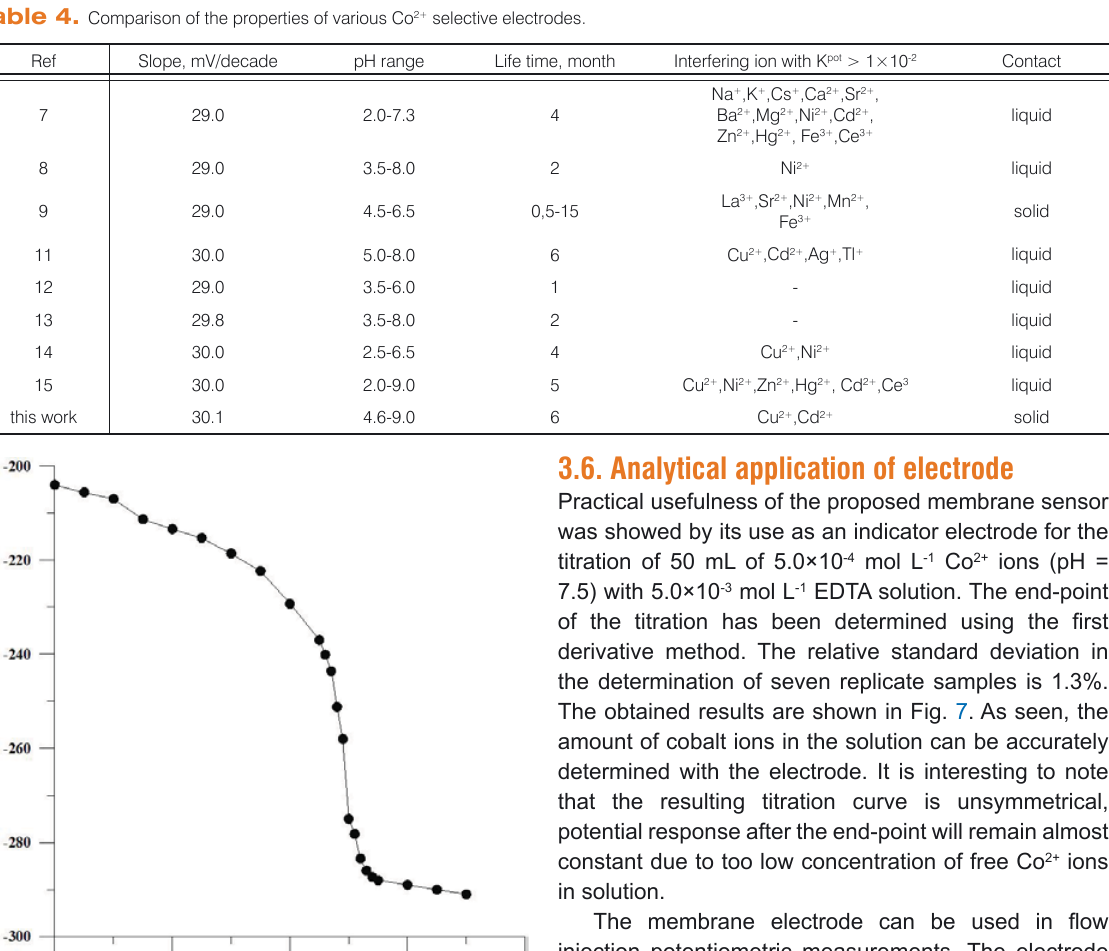
a. results are based on three measurements.